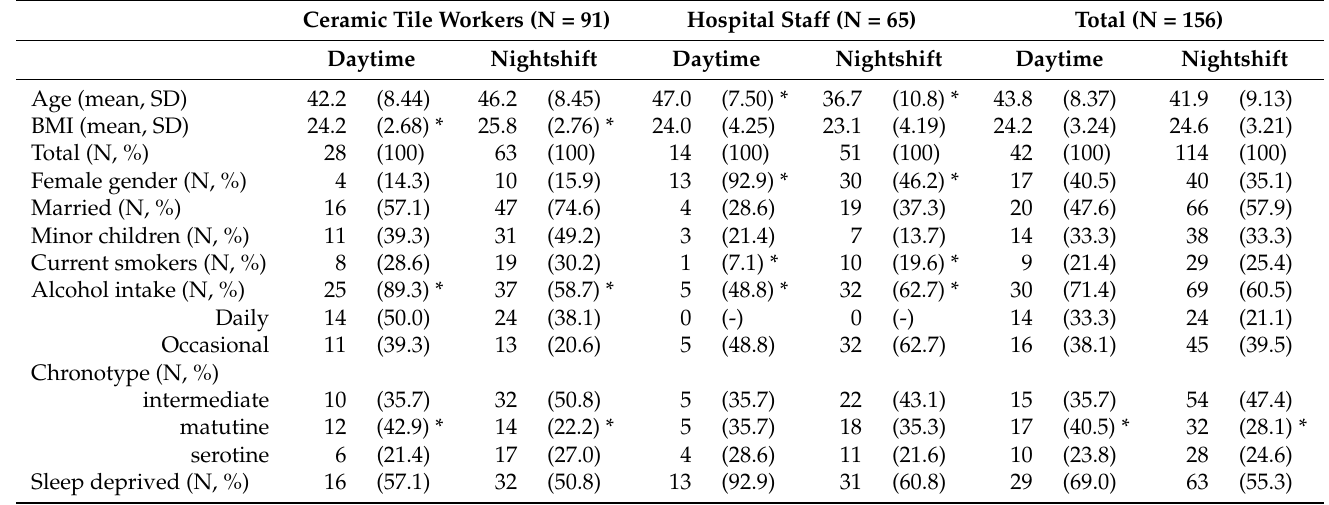
Table 2. Selected variables of the study population by workplace and by type of work